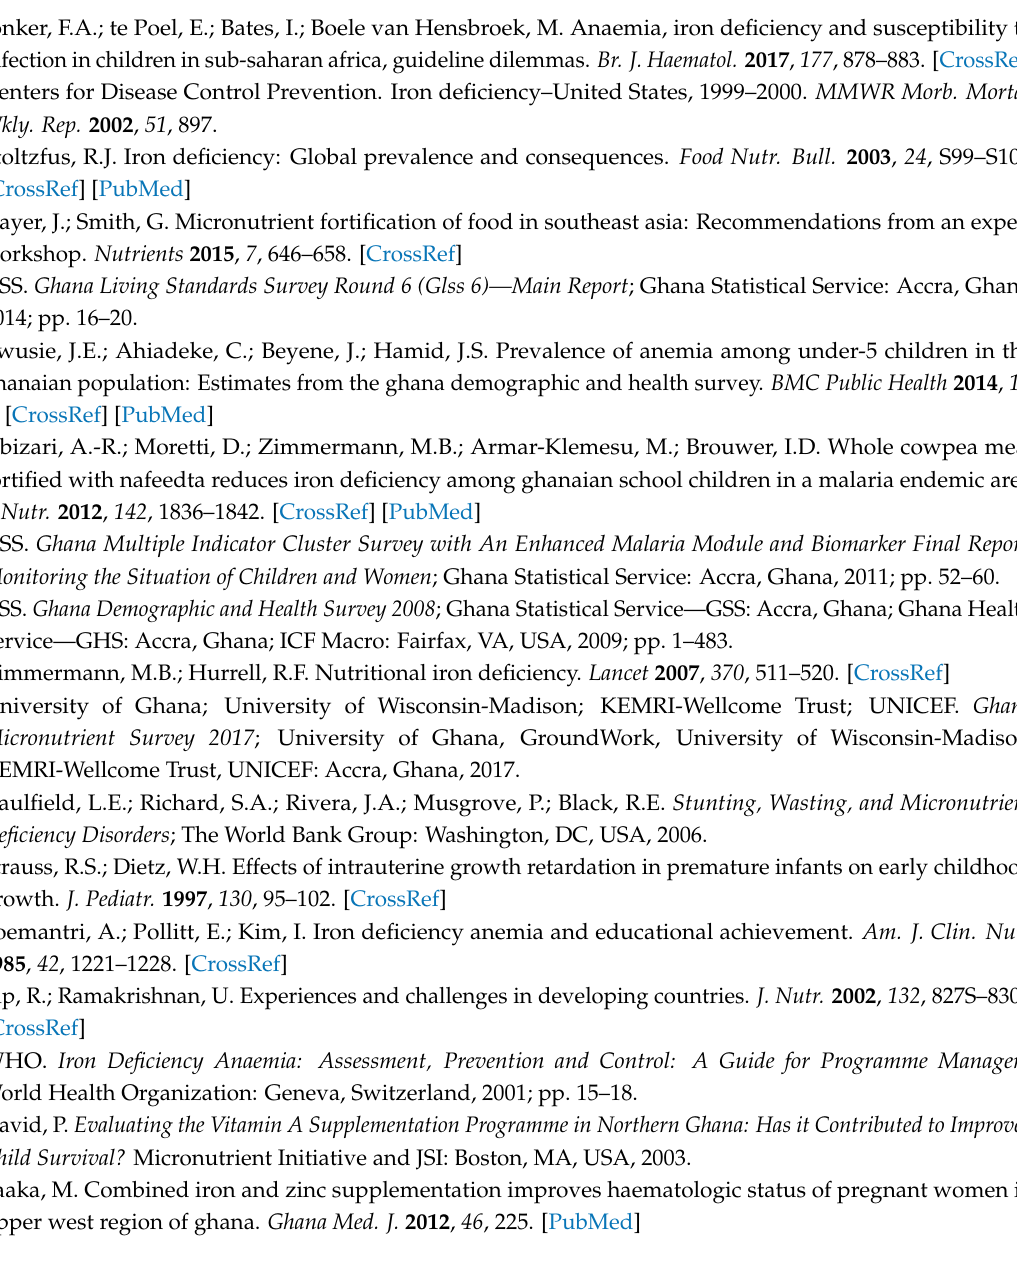
Table S1: Nutrient composition of HSM and its